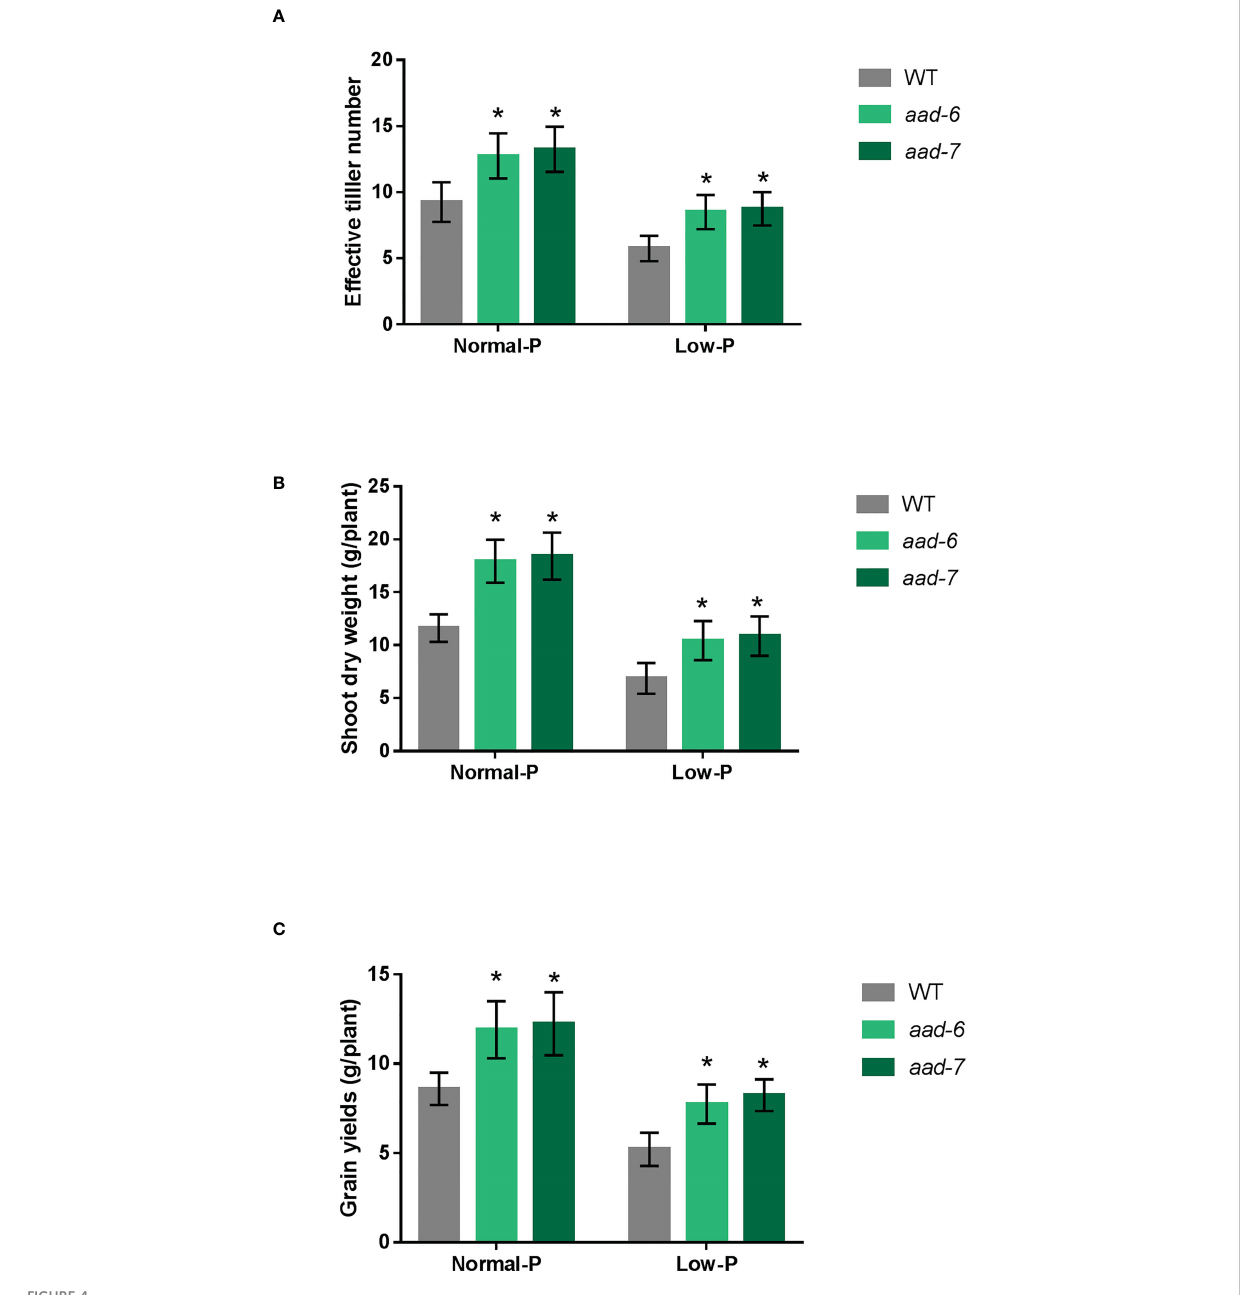
FIGURE 4 Growth performances of the wild-type and aad mutants under normal and low Pi supply in a pot experiment. (A) Effective tiller number per plant. (B) Shoot dry weight per plant. (C) Grain yields per plant. Values represent means ± SD of four biological replicates *P <